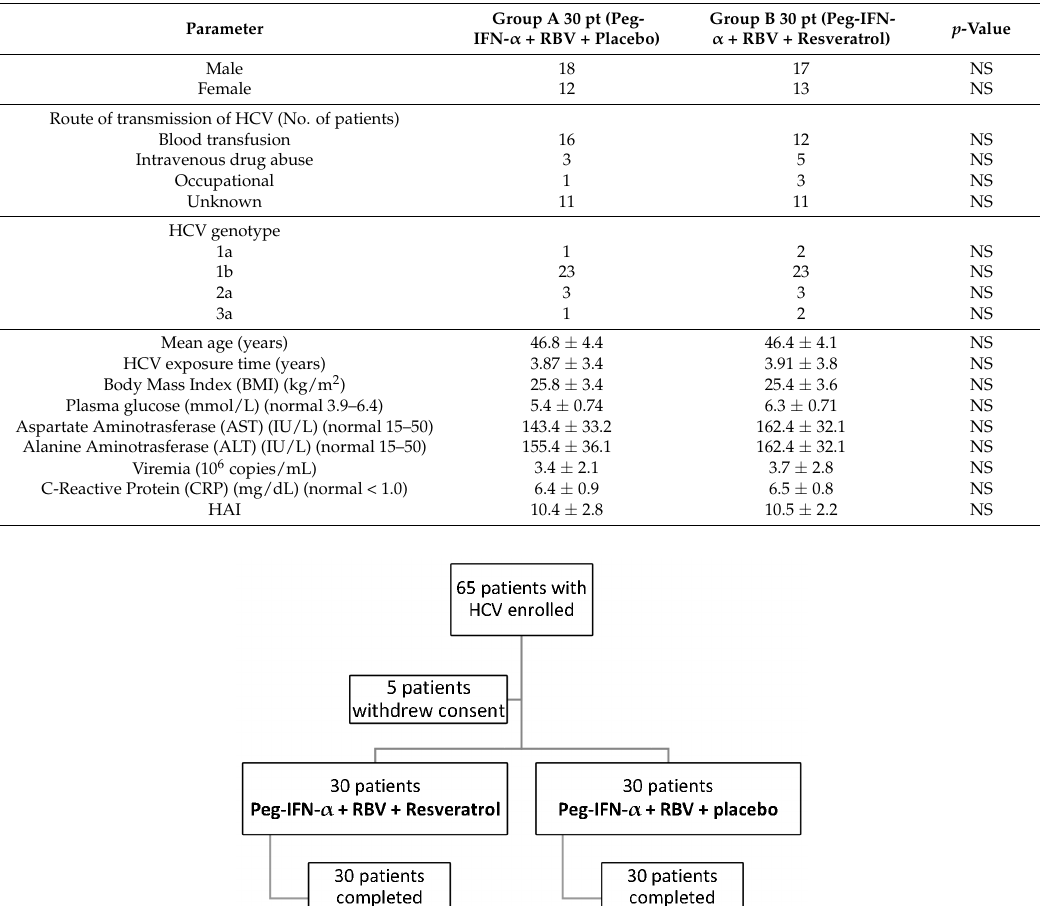
Table 1. Patients characteristics at liver biopsy.